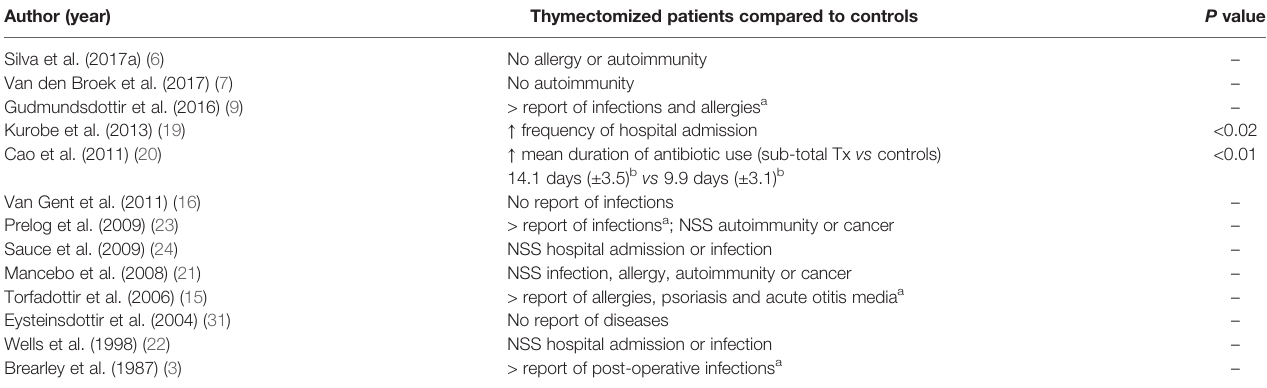
TABLE 3 | Main results regarding clinical outcomes of included studies.